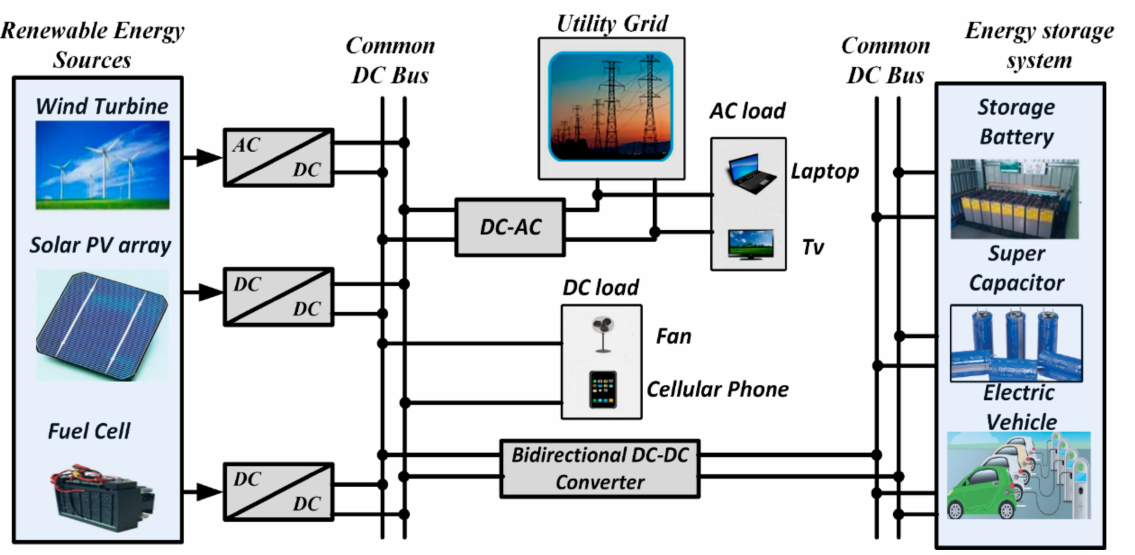
Figure 1. Application of power electronic converters in a renewable energy